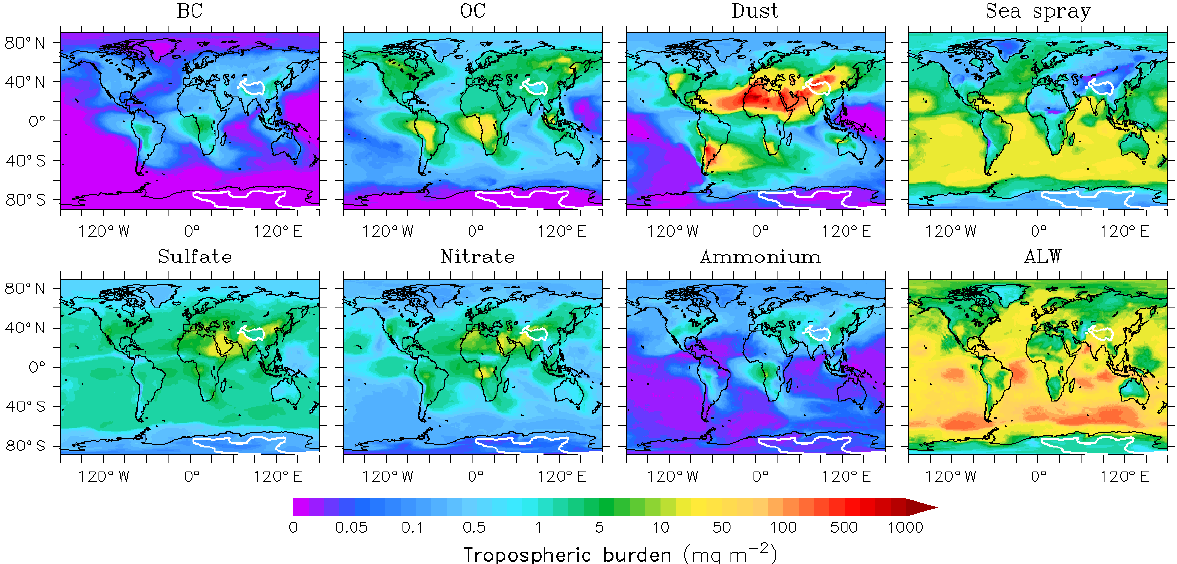
Figure 3. EMAC-simulated global distributions of the tropospheric burden (in units of mgm − 2 ) of black carbon (BC), organic compounds (OC), mineral dust, sea spray, sulfate, nitrate, ammonium, and aerosol liquid water (ALW), averaged for July–August 2012. White lines refer to the terrain height contour of 3km, highlighting the Tibetan Plateau area in the Northern